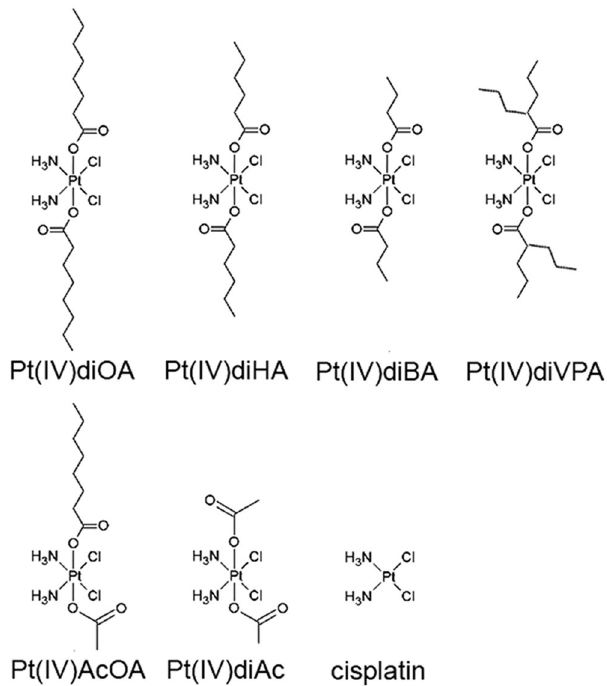
Figure 1. Schematic representation of the platinum compounds used in the present